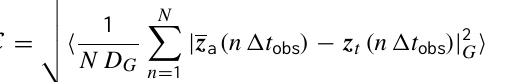
Fig. 5. Rms error of the analysis as a function of the observation interval ∆ t obs (in hours) for the slow variables x .